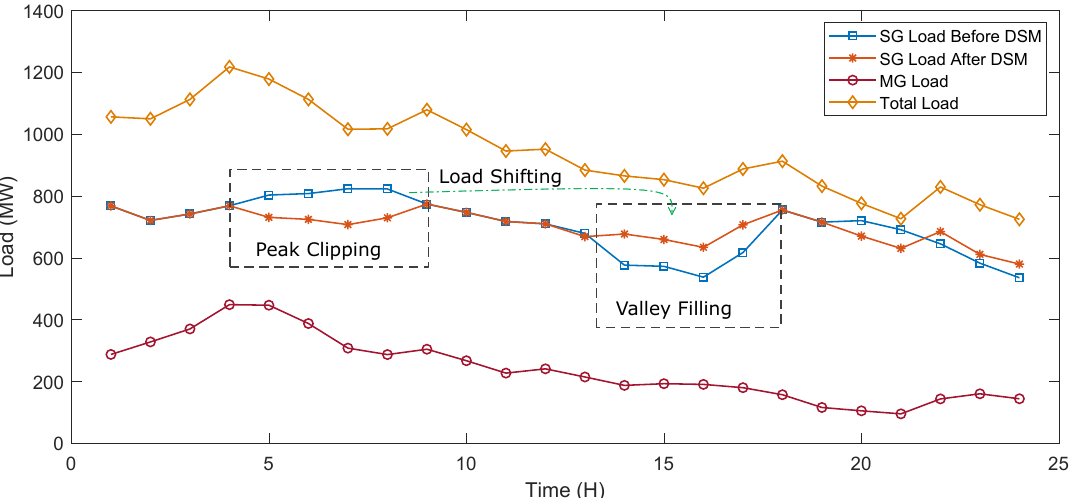
Figure 5. Valley filling and peak clipping through Efficient DSM